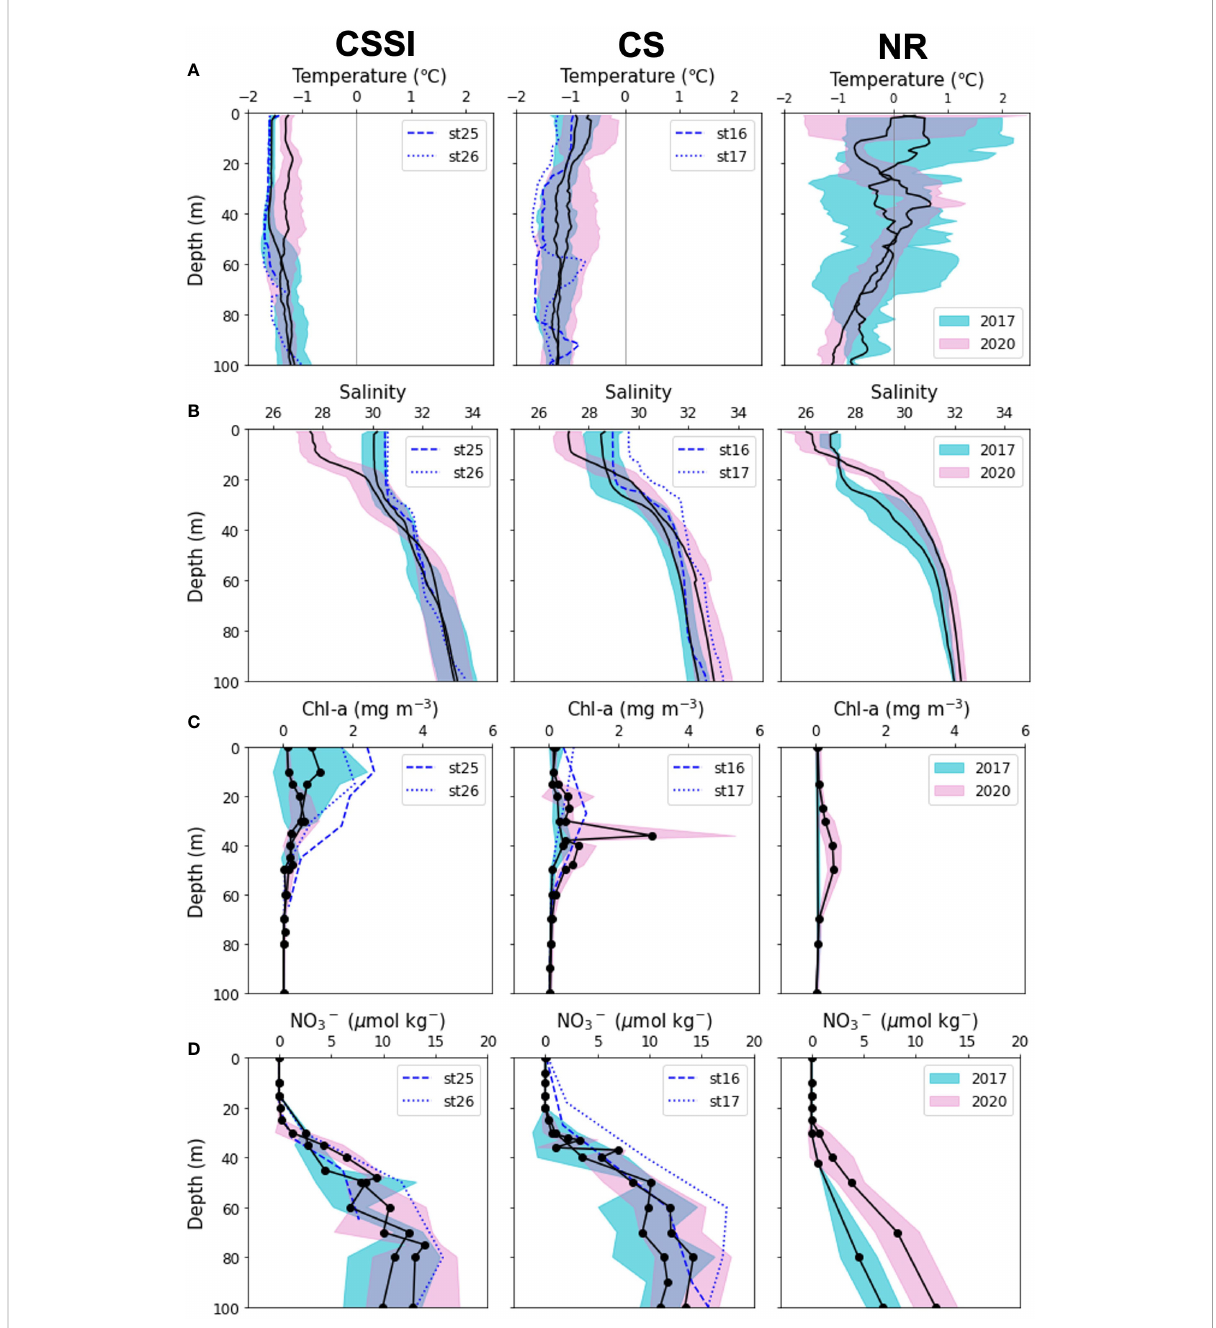
FIGURE 4 Regional vertical pro fi les of (A) temperature, (B) salinity, (C) nitrate, and (D) Chl- a . Means and standard deviations of the parameters are shown in lines and shades,